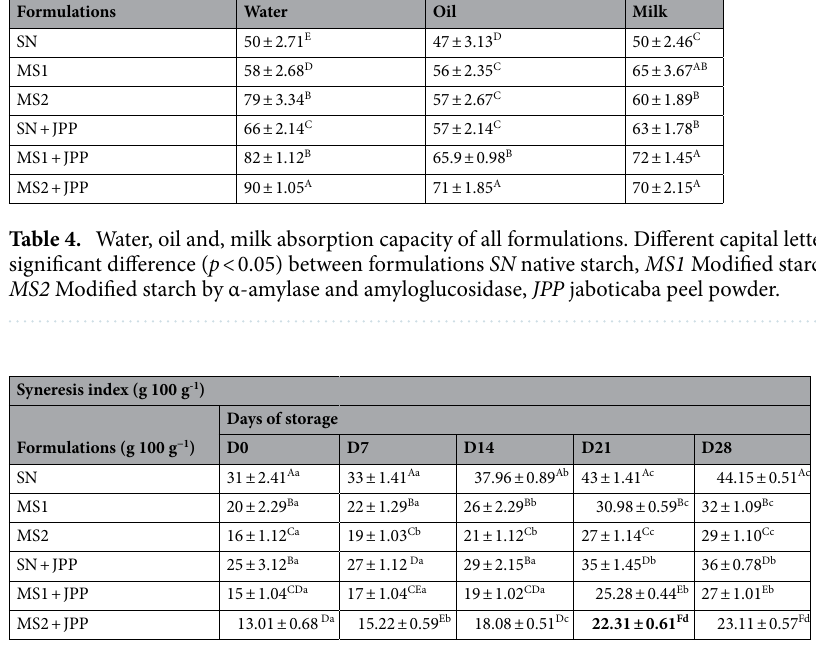
Table 5. Syneresis index throughout the 28-day storage period. Different superscript uppercase letters denote significant differences between formulations for the same storage day (p < 0.05). Different superscript lowercase letters denote significant differences between the storage days for the same formulation (p < 0.05). SN native starch, MS1 Modified starch by α-amylase, MS2 Modified starch by α-amylase and amyloglucosidase, JPP jaboticaba peel